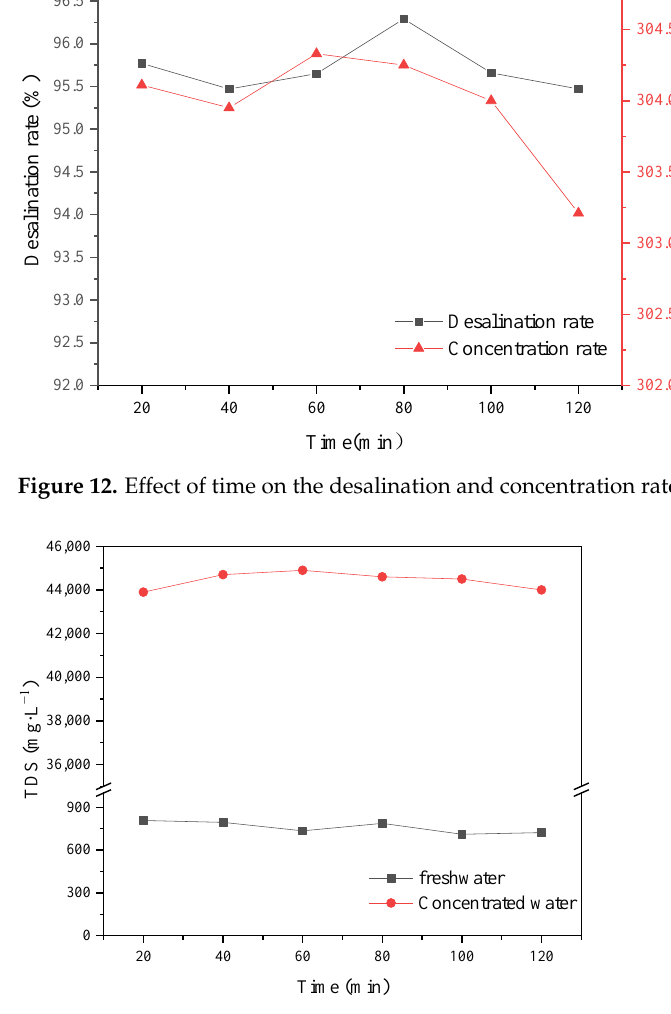
Figure 13. Effect of time on TDS.